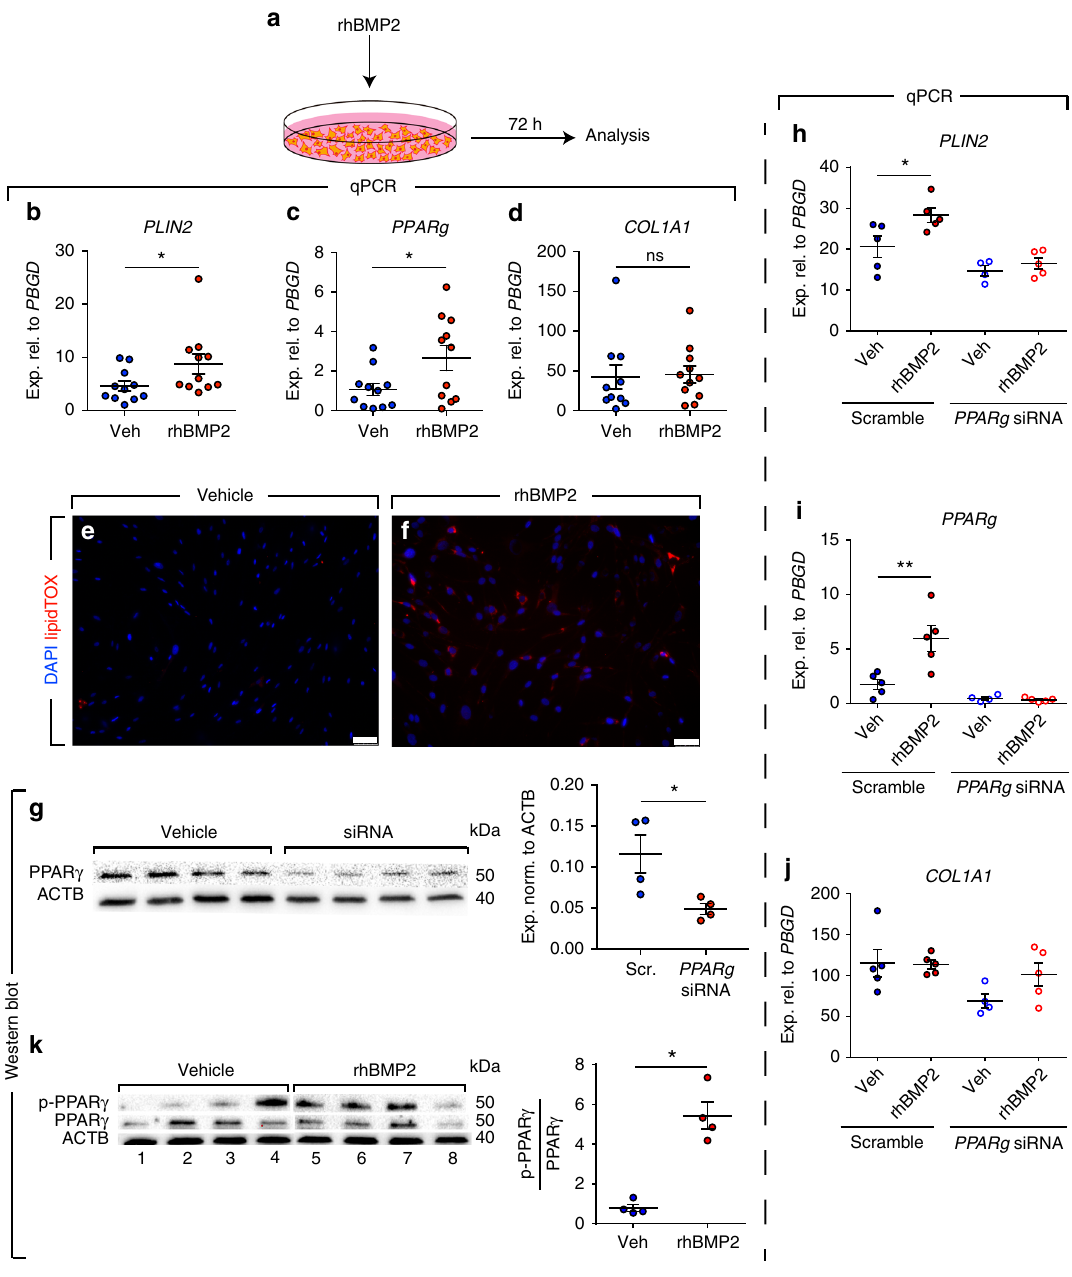
Fig. 6 rhBMP2 induces PPAR γ phosphorylation and lipogenic differentiation in human IPF lung fi broblasts. a Schematic representation of the experimental setup. b – d qPCR analysis of PLIN2, PPARg and COL1A1 in IPF fi broblasts treated with rhBMP2 or vehicle. e , f Staining of rhBMP2- and vehicle-treated cells with LipidTOX (red) and DAPI (blue). g Western blot validating the knockdown of PPAR γ protein levels 72 h after siRNA treatment. Quanti fi cation of the immunoblot is shown in the right panel. h – j qPCR analysis of PLIN2, PPARg , and COL1A1 in IPF fi broblasts transfected with siRNA against PPARg (for 72 h) and then treated with vehicle or rhBMP2 for 72 h. k Western blot showing the induction of PPAR γ phosphorylation in response to rhBMP2 treatment. Lanes 1 – 4 and lanes 5 – 8 were run in parallel on different gels under the same conditions. Quanti fi cation of the immunoblot is shown in the right panel. Scale bars: e – f 50 µ m. Each data point corresponds to one patient and error bars indicate s.e.m. b – d n = 11 per group except for COL1A1 vehicle-treated group ( n =